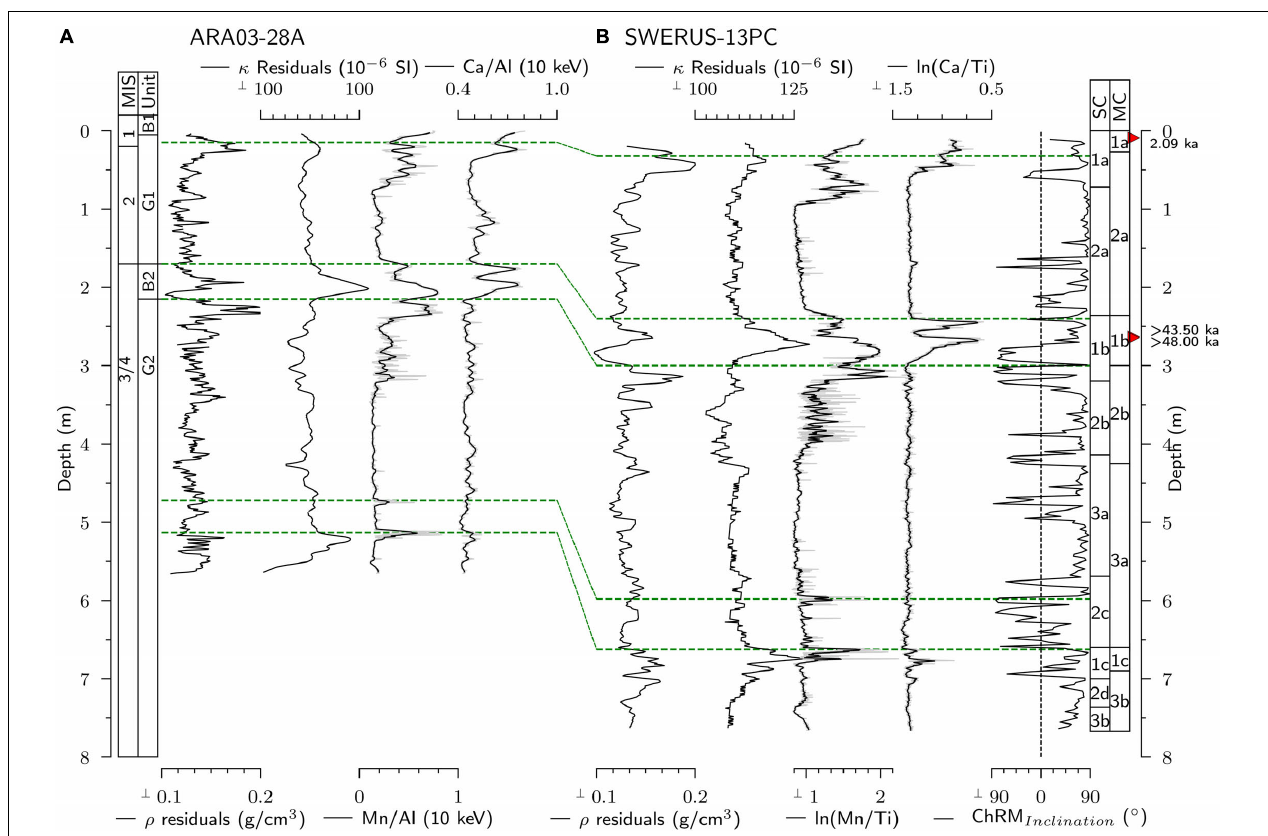
FIGURE 7 | Correlation of sediment cores ARA03-28A (28A) and SWERUS-13PC (13PC; c.f., Figure 1 for core locations) based on bulk density ( ρ ) residuals, volume magnetic susceptibility ( κ ) residuals, manganese (Mn) content and calcium (Ca) content. (A) parameters of 28A with the location of marine isotope stage (MIS) boundaries and locations of brown and grey layers as presented by Schreck et al. (2018). (B) parameters for SWERUS-13PC with characteristic remanent magnetisation (ChRM) inclination and fuzzy c-means cluster (FCM) results from physical (SC) and magnetic (MC) properties. Position and age of three radiocarbon ages (uncorrected ages; 14 C yrs BP) are shown as red